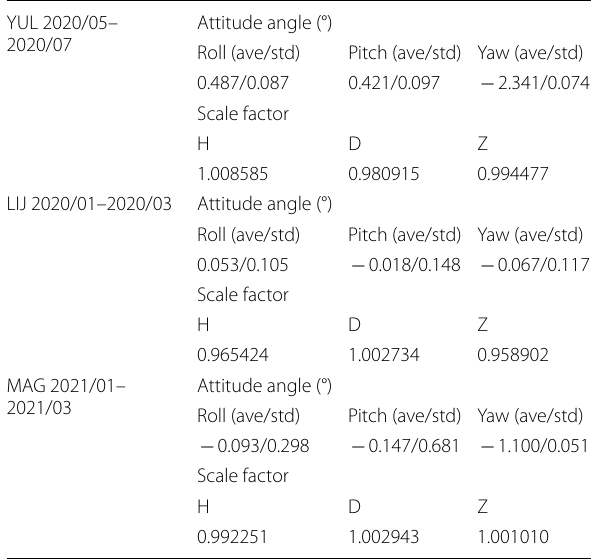
Table 2 Calculation results for the attitude angle and the scale factor